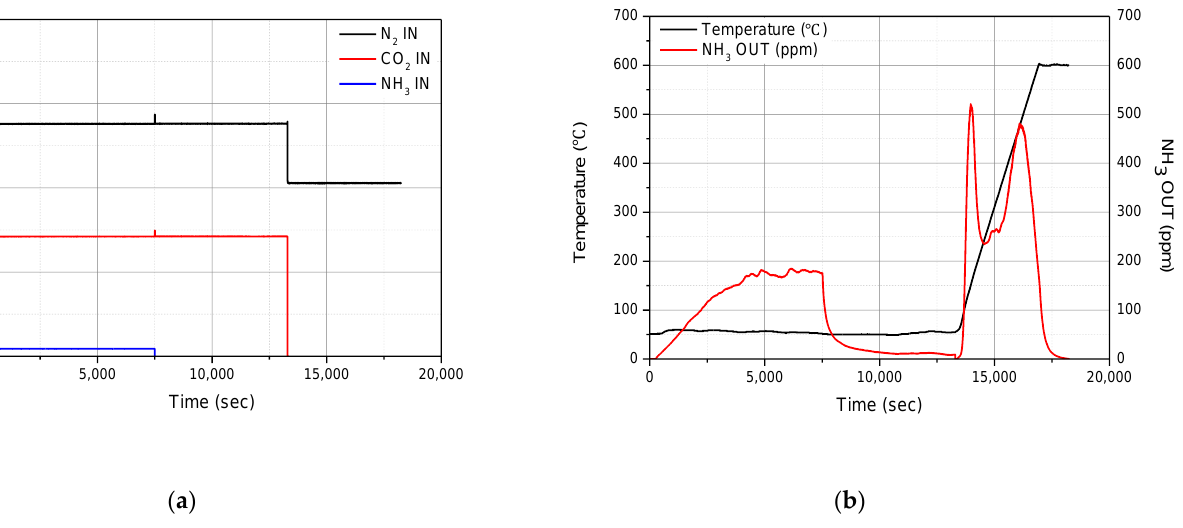
Figure 13. Changes in gas supply amount, temperature, and NH 3 concentration with time, describing the experimental procedure: ( a ) Gas-feeding amount; ( b ) temperature and NH 3 gas concentration.